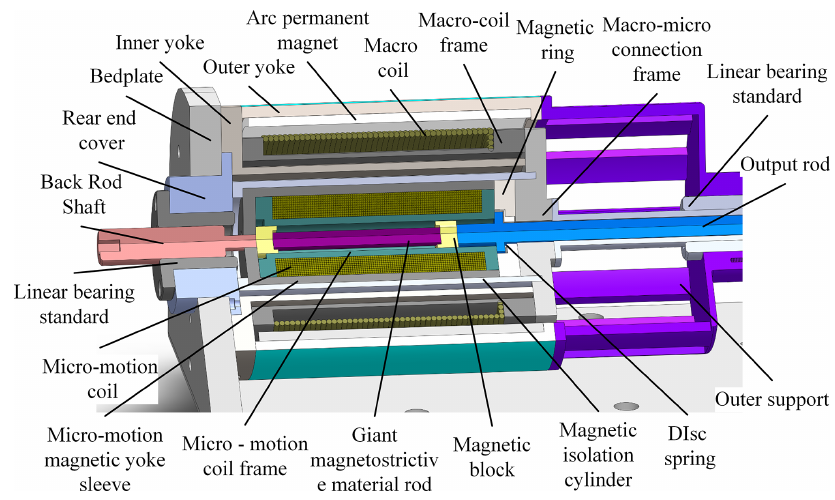
Figure 1. Structure diagram of the macro–micro composite actuator.